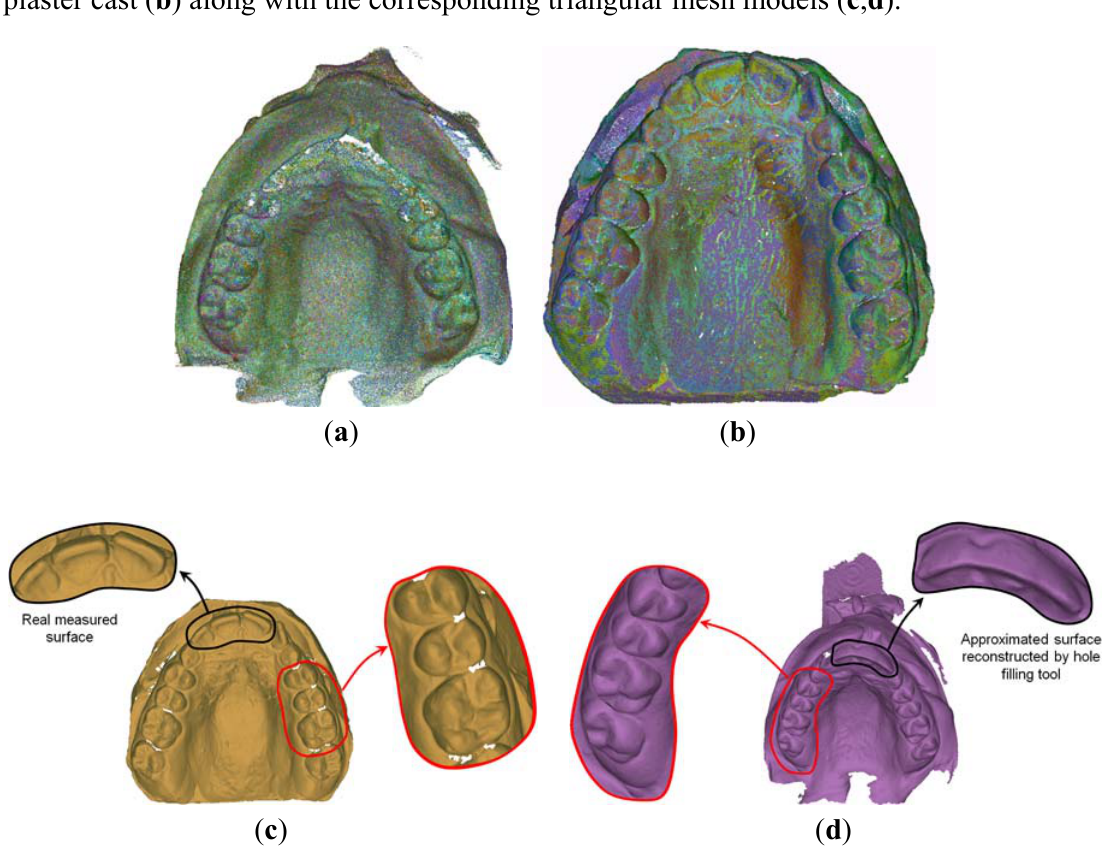
Figure 4. Aligned scans relative to the acquisition of the mouth impression ( a ) and the plaster cast ( b ) along with the corresponding triangular mesh models ( c , d